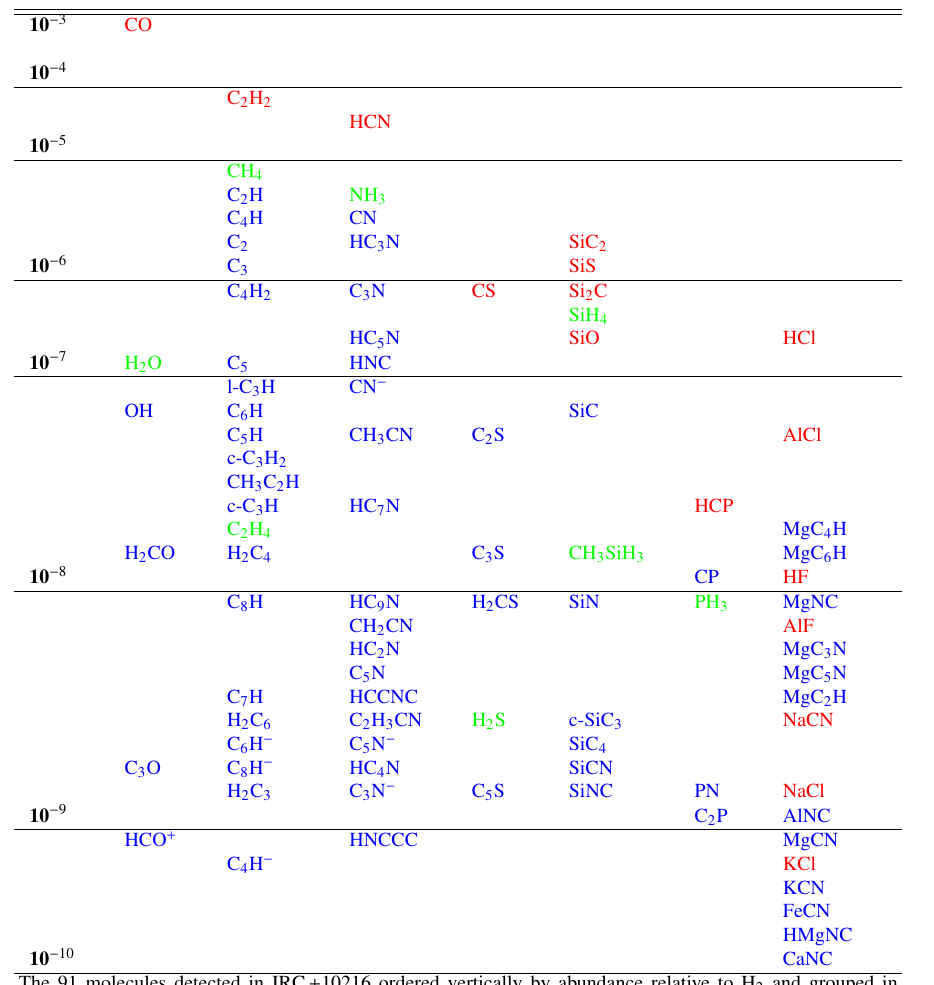
Table 1. The 91 molecules detected in IRC + 10216 (as of July 2022) . Table 2. The 27 + 7 molecules detected in oxygen-rich AGB envelopes (as of July 2022)